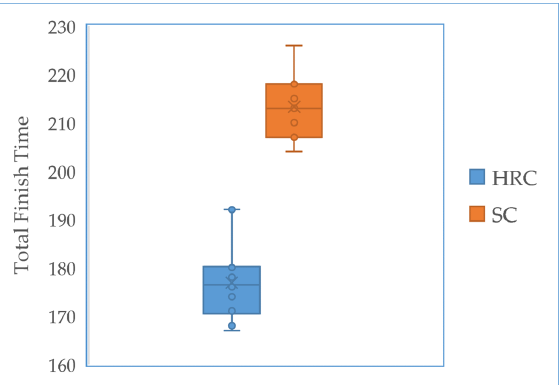
Figure 18. Total finish time comparison between human-robot collaboration with early prediction and speech commanded assistance.